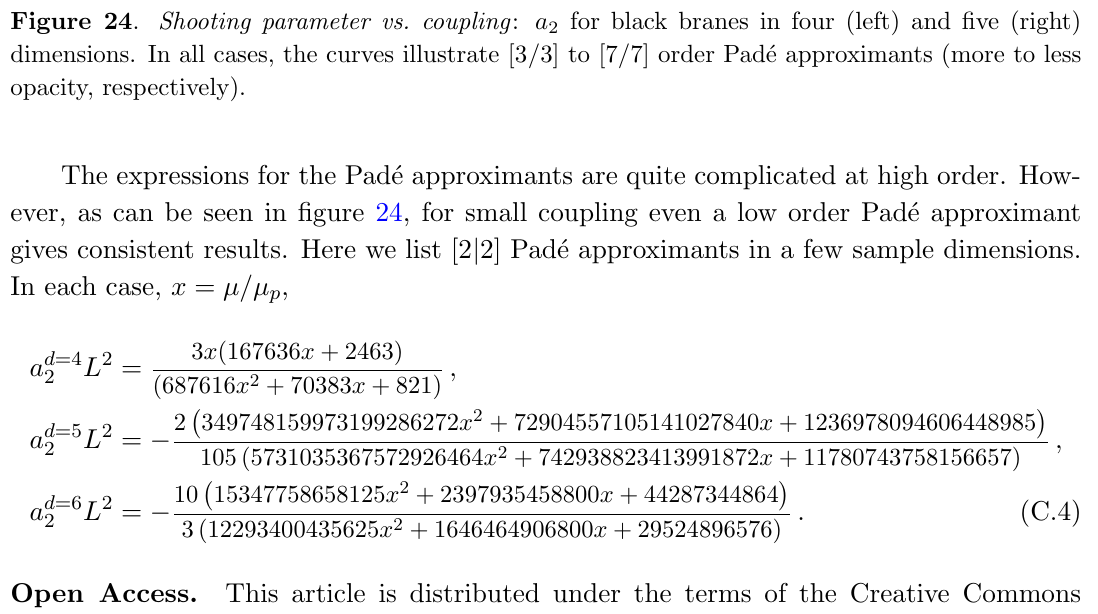
for black branes in four (left) and five (right) 2